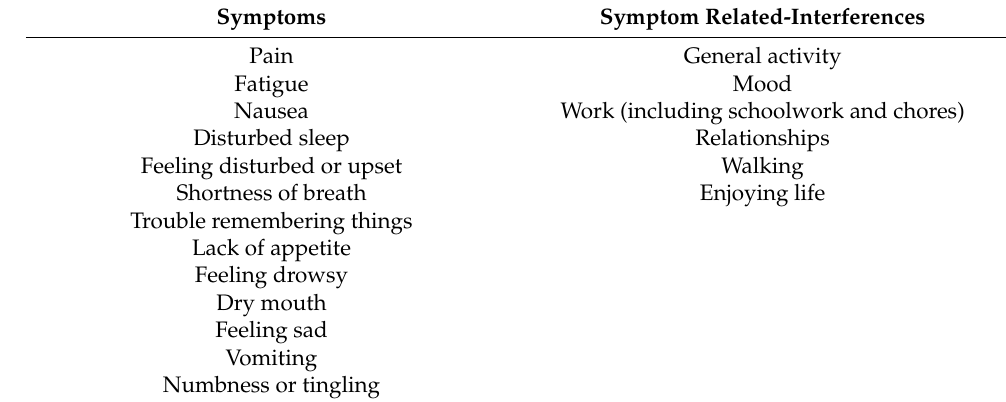
Table 1. Symptoms and the domains of daily living in which those symptoms interfere as described on the MDASI-Adolescent (MDASI-Adol)